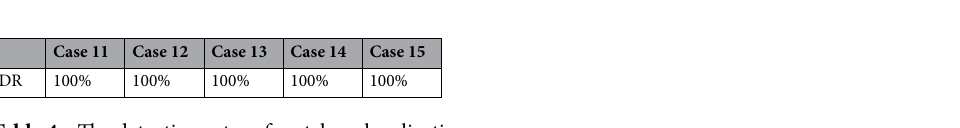
Table 4. The detection rates of vertebrae